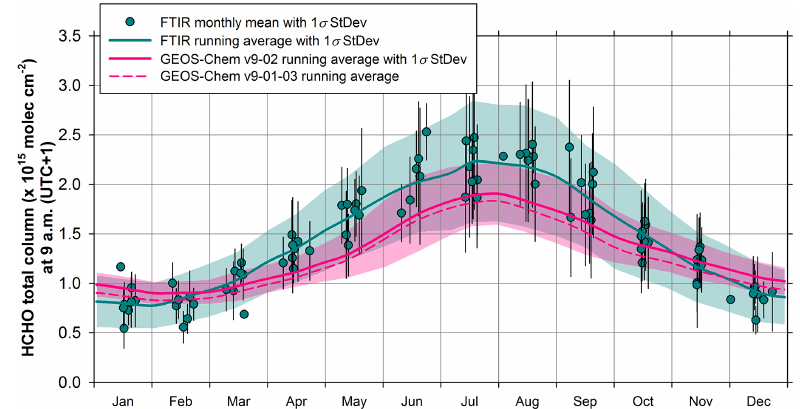
Figure 4. Monthly averaged total columns of HCHO and associated 1 σ bars displayed on a 1-year time base, from the individual 09:00 (UTC + 1) scaled FTIR measurements performed above the ISSJ between July 2005 and May 2013. Note that the daily observation values with relative anomalies to the curve fit calculated by Gardiner et al. (2008, Sect. 5.2), higher than the 95th percentile value of all relative anomalies of the data set, have been excluded from the present data set. The green curve and shaded area show on a 1-year time base the running mean fit to the daily averaged columns (with a 2-month wide integration time and a 15-day time step) and the associated 1 σ standard deviation, respectively. The solid red line and shaded area represent corresponding information, but deduced from the smoothed outputs of the GEOS-Chem v9-02 standard run. The dashed red line corresponds to the same 1-year time base running mean, but obtained from the smoothed outputs of the GEOS-Chem v9-01-03 standard run. Note that the 1 σ standard deviations around the running mean are calculated on the basis of the daily averaged columns and hence include inter-annual fluctuations as well as variability of the monthly mean.